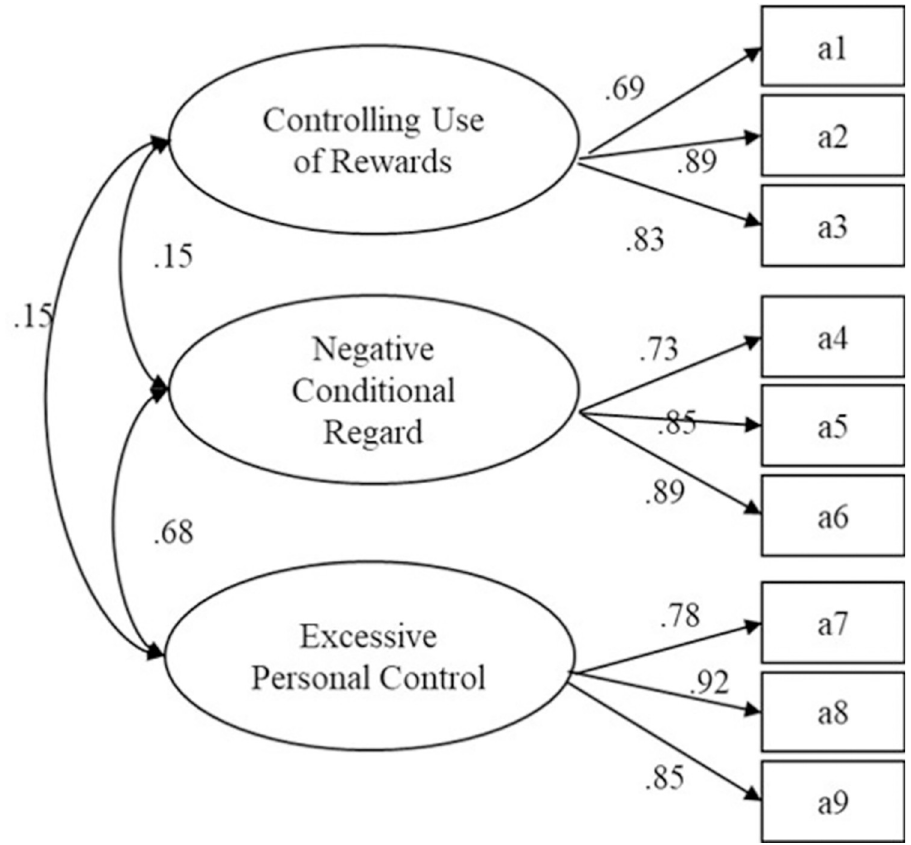
Fig 1. Results of three-factor confirmatory factor analysis of the Controlling Coach Behaviors Scale.